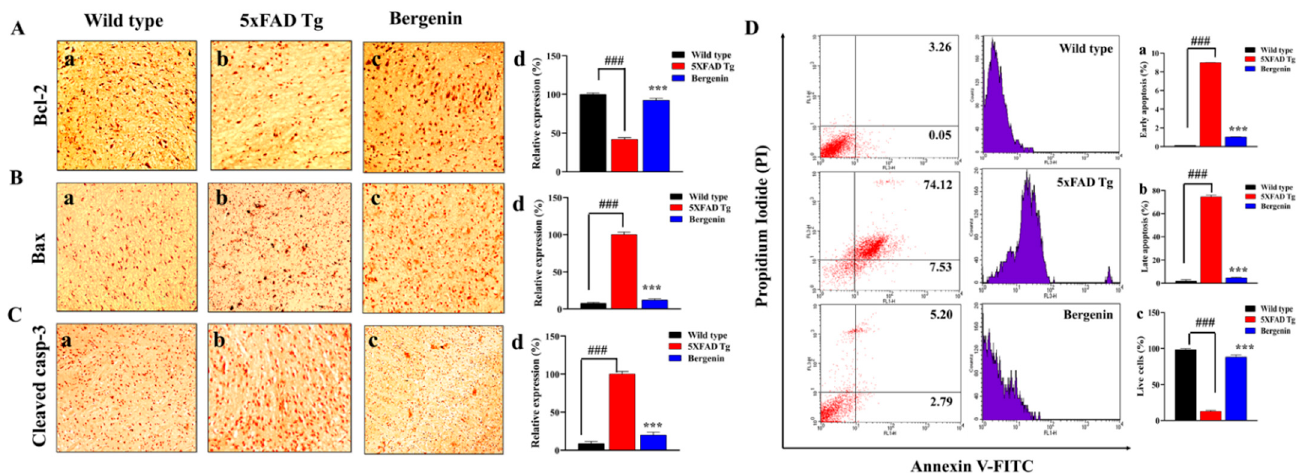
Figure 10. Immunohistochemical analysis of ( A ) Bcl-2, ( B ) Bax and ( C ) Cleaved caspase-3 proteins in hippocampal regions of the brain in ( a ) wild-type, ( b ) 5xFAD Tg, and ( c ) Bergenin-treated groups, where ( d ) represents a quantitative analysis of (%) relative expression of proteins. ( B ) Flow cytometry representing Annexin V/FITC and propidium iodide staining in hippocampal neuronal cells in ( a ) wild-type, ( b ) 5xFAD Tg, and ( c ) Bergenin-treated groups. Quantitative analysis were represented by ( a ) (%) early apoptosis, ( b ) (%) late apoptosis, and ( c ) (%) live cells. Scale bar = 50 µm. Results were expressed as mean ± S.D. *** p < 0.001 versus the 5xFAD Tg mice group, ### p < 0.001 versus the wild type.